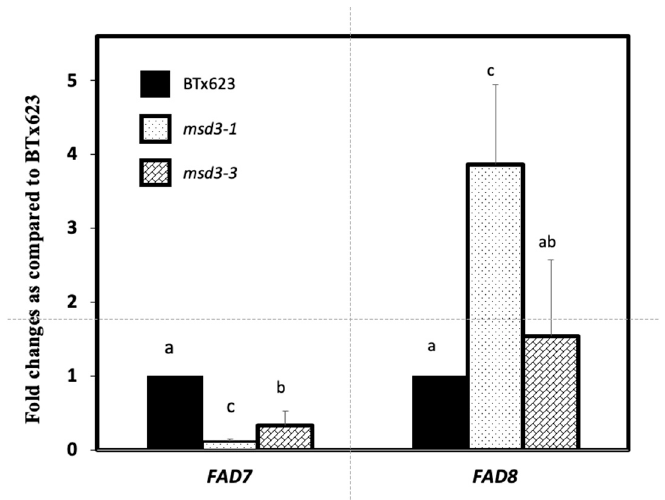
Figure 5. Expression of FAD7 and FAD8 genes in developing panicles. Relative change in FAD7 and FAD8 mRNA levels in msd3 mutants in comparison to BTx623 (normalized as